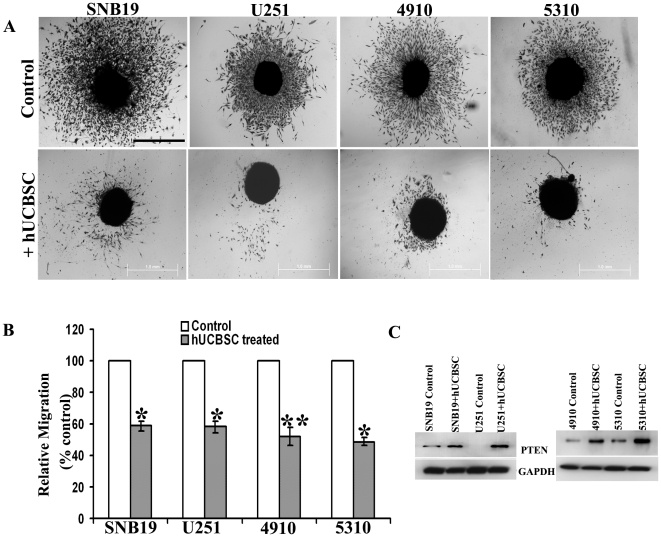
Conditioned medium from co-culture of glioma cells with hUCBSC inhibits spheroid migration.(A) SNB19, U251, 4910 and 5310 cells were cultured in 96-well low attachment plates at a concentration of 5×104 cells, and spheroids were allowed to grow for 24 h at 37°C with shaking at 40–60 rpm. The spheroids were then transferred to 48-well plates and maintained for another 24–48 h in conditioned media from single cultures and co-cultures. Spheroid migration was analyzed using a phase-contrast microscope. Scale bar  = 1000 µm. (B) Quantitative analysis of spheroid migration from (A). Error bars indicate SEM. *p <0.05. **p <0.01. n = 3. (C) Immunoblot analysis of PTEN from glioma cells grown in their respective control conditioned media and co-culture conditioned media.